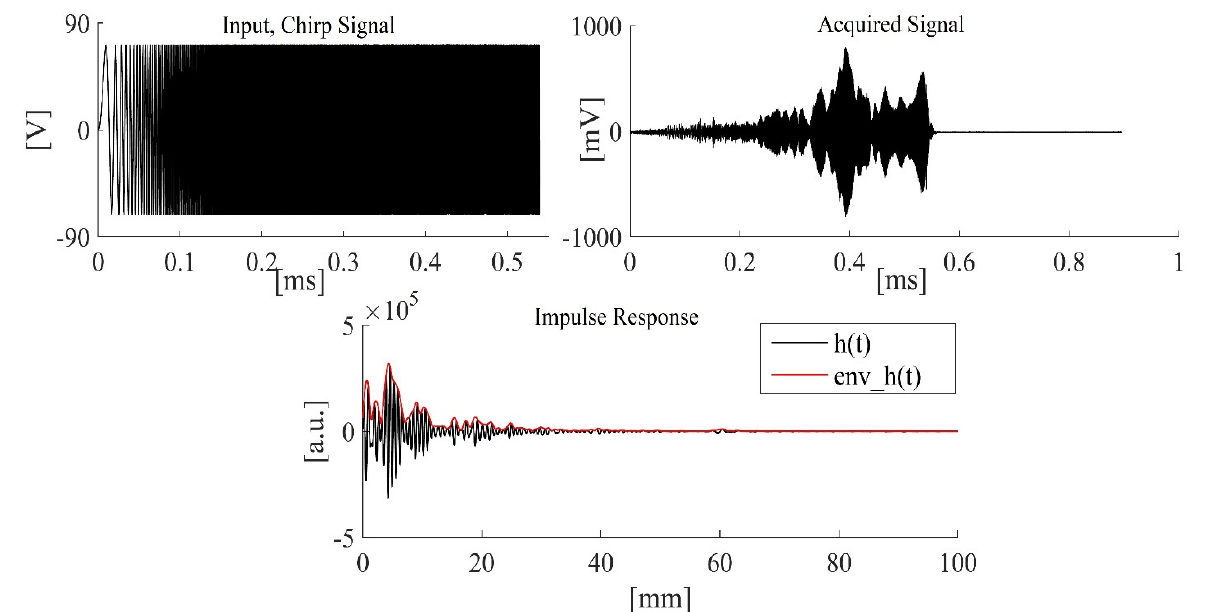
Figure 4. Examples of the signals involved in the pulse compression ultrasonic measurement: the input chirp signal ( top-left ) applied to the transmitting element; the echo signal acquired through the reception element of the array transducer ( top-right ); the impulse response of the sample under test (SUT) retrieved by convolving the acquired signal with the matched filter ( bottom ).